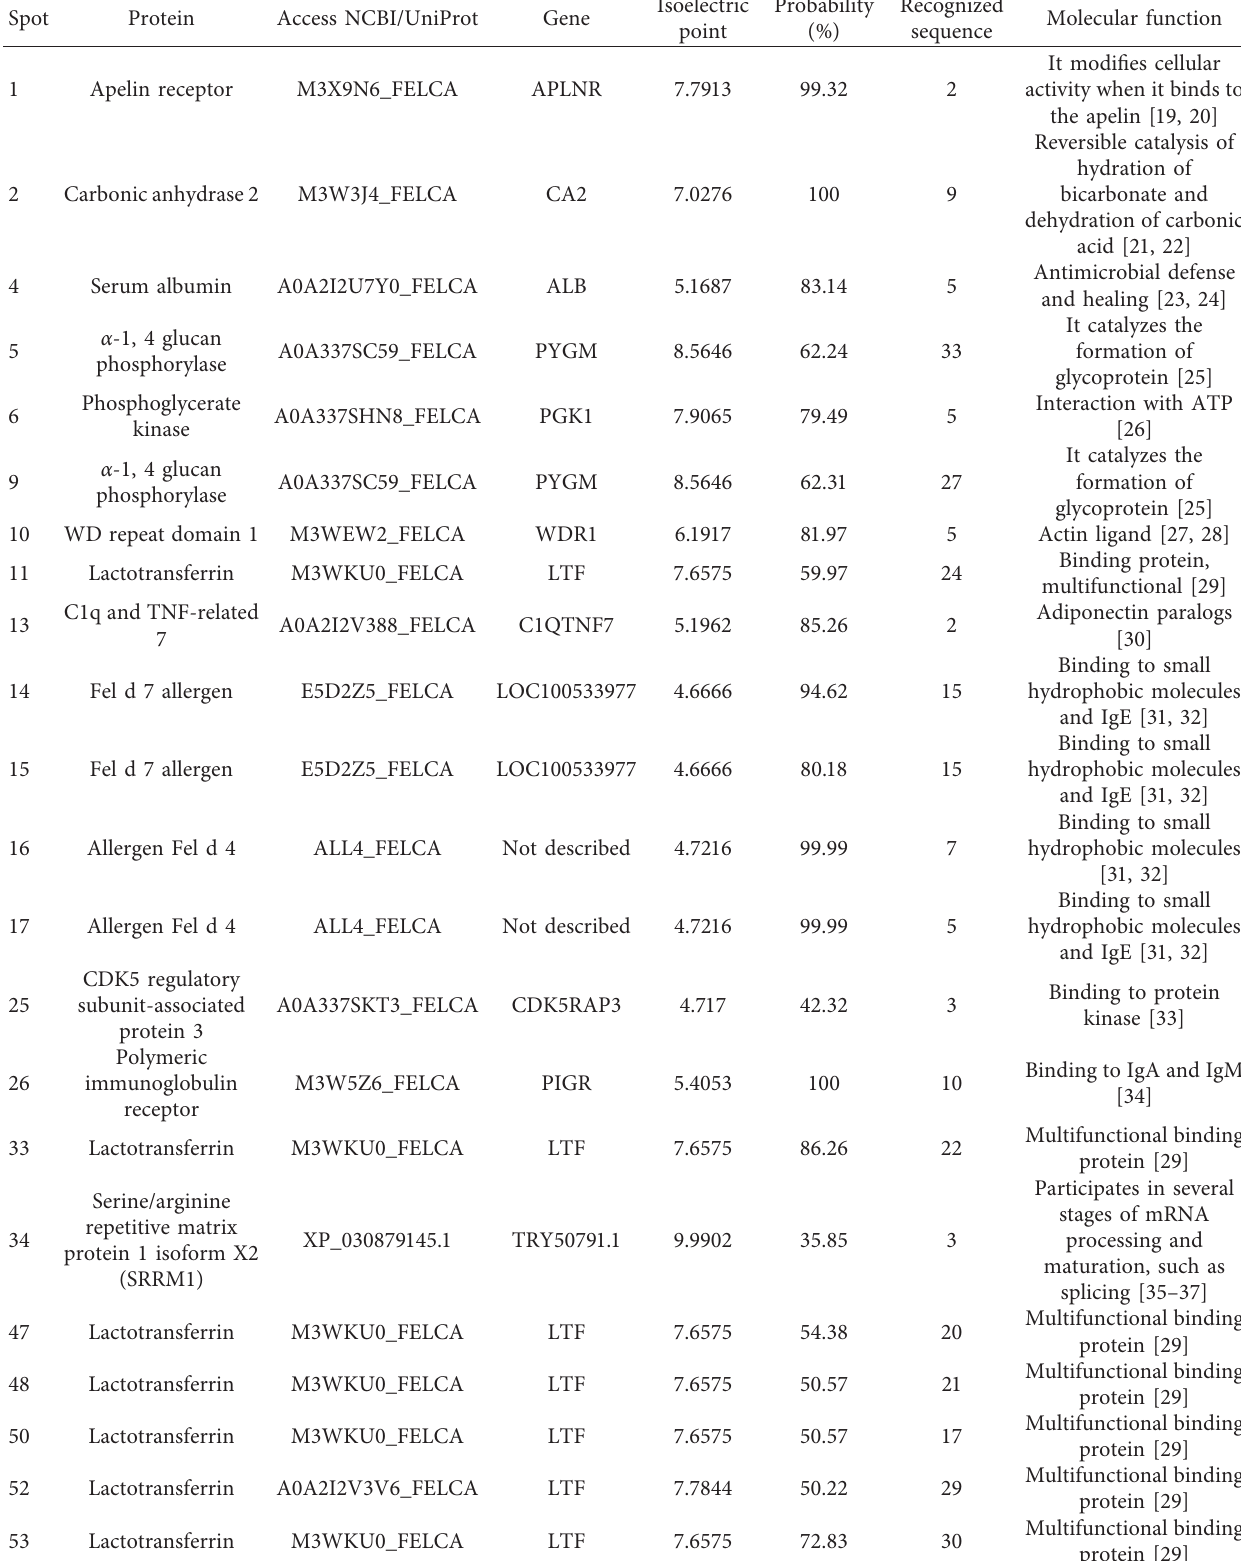
Table 1: Peptides identified in the tear of healthy